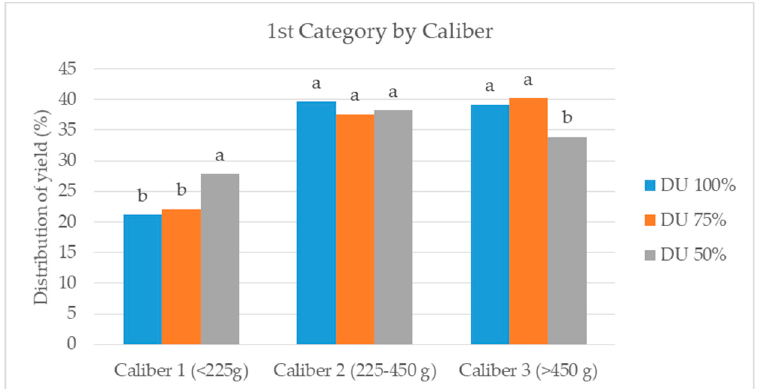
Figure 4. Distribution of 1st Category by Caliber of the yield. Columns marked with different lower case letters denote significant di ff erences between DU levels by Caliber. * significance for p ≤ 0.05; case letters denote significant differences between DU levels by Caliber. * significance for p ≤ 0.05; ns, ns, no significance. Di ff erent letters describe significant di ff erences between levels of DU for no significance. Different letters describe significant differences between levels of DU for calibers.